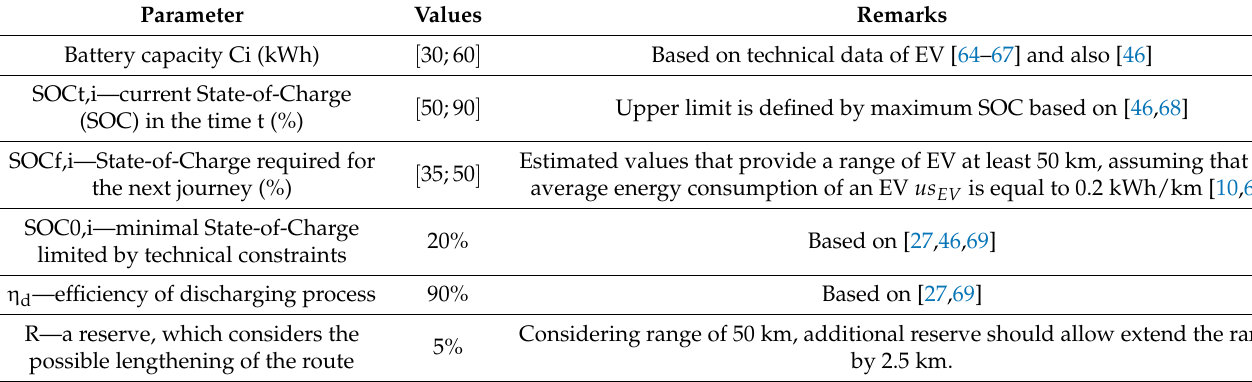
Table 3. Parameters used in simulation of the proposed